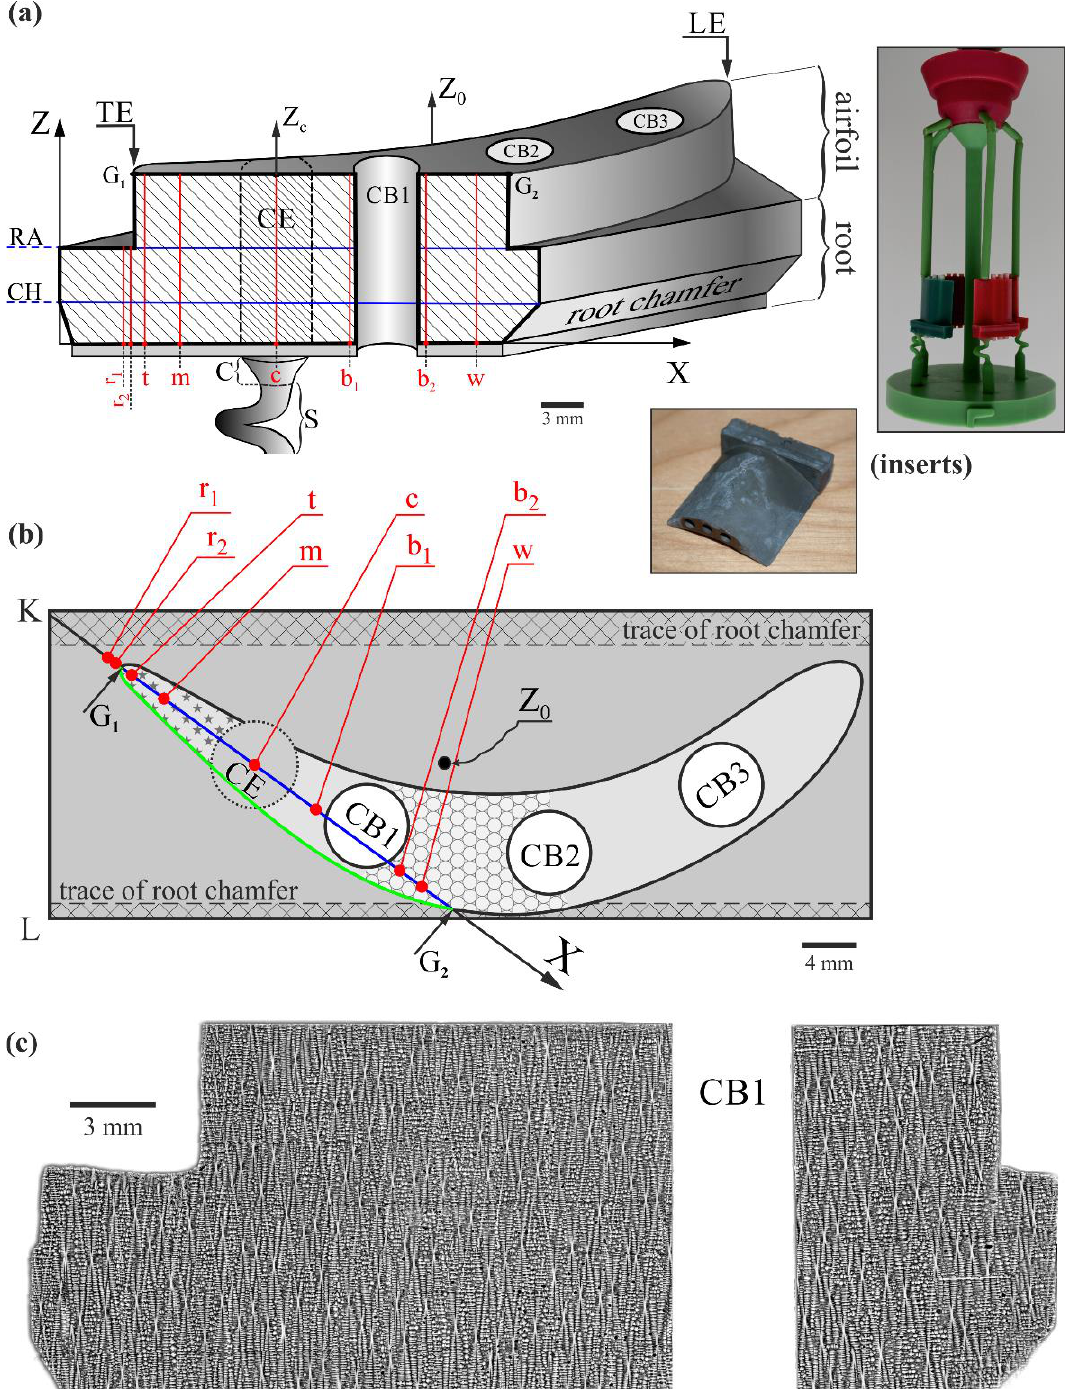
Figure 1. The shape of a model blade with a prepared longitudinal section ( a ) and the top view ( b ), and the dendritic structure of the analyzed section (SEM BSE) ( c ). Inserts show the wax model assembly and produced blade cast. Z 0 —main vertical axis of the blade; CH—chamfer level; RA—root– airfoil connection level; r 1 , r 2 , t, m, c, b 1 , b 2 , w—measurement lines; Z c —the exemplary axis of the measurement line c, the axes of the other lines have not been marked for the figure’s clarity; TE, LE—trailing and leading edges of the airfoil, respectively; S—spiral selector; C—selector continuer; CE—continuer extension; CB1, CB2, CB3—cooling bores. A description of other symbols is provided in the text.